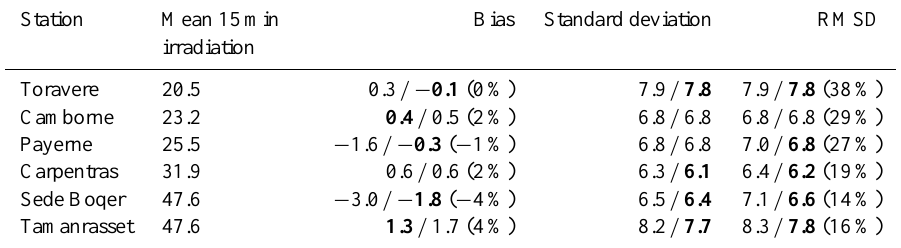
Table 3. Comparison of differences for 15min irradiation, in Jcm − 2 . The mean value is obtained from the measurements. The first value is I HC3v3 and the second is I HC3McClear , with the best value in bold. Bias and RMSD of I HC3McClear relative to the mean irradiation are given in brackets.